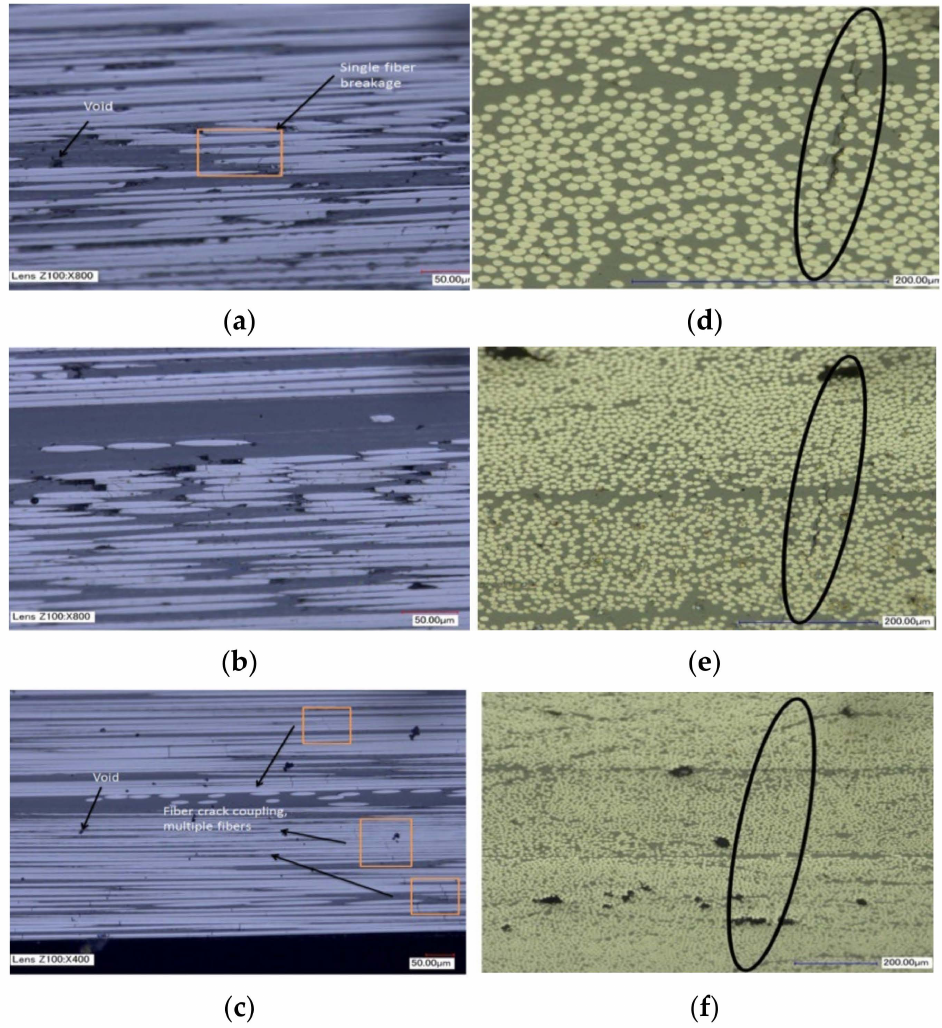
Figure 12. Micrographies of unidirectional specimen ( a ) at proportional limit, ( b ) at 0.9 kN, and ( c ) at 1.1 kN; angle-ply specimen ( d ) at proportional limit, ( e ) at 0.11 kN, ( f ) and at 0.14 kN (microcracking